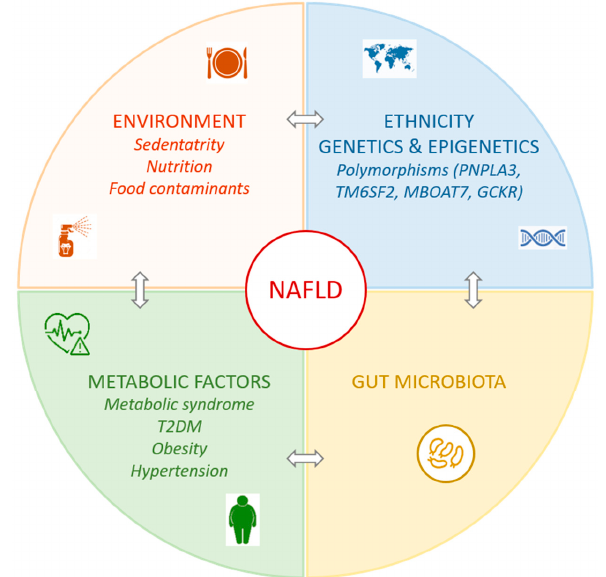
Figure 1. Non-alcoholic fatty liver disease (NAFLD) determinants. Multiple factors contribute to the development of NAFLD and its progression. Obesity and T2DM are closely associated with NAFLD, and both drive the increasing prevalence of NAFLD. The genetic background also strongly influences disease development. In addition, the progression of NAFLD depends on complex interactions between genetic and environmental factors, especially dietary factors. More recently, the gut microbiota has emerged as an important determinant of NAFLD pathogenesis. Abbreviations: NAFLD, non-alcoholic fatty liver disease; T2DM, type 2 diabetes mellitus; PNPLA3, patatin-like